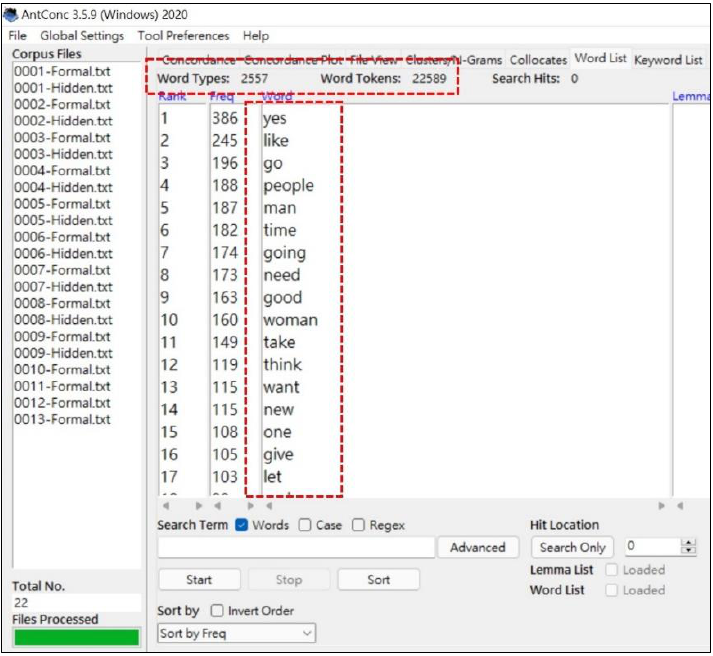
Figure 8. CEFR A2 level words that exist on the target corpus.